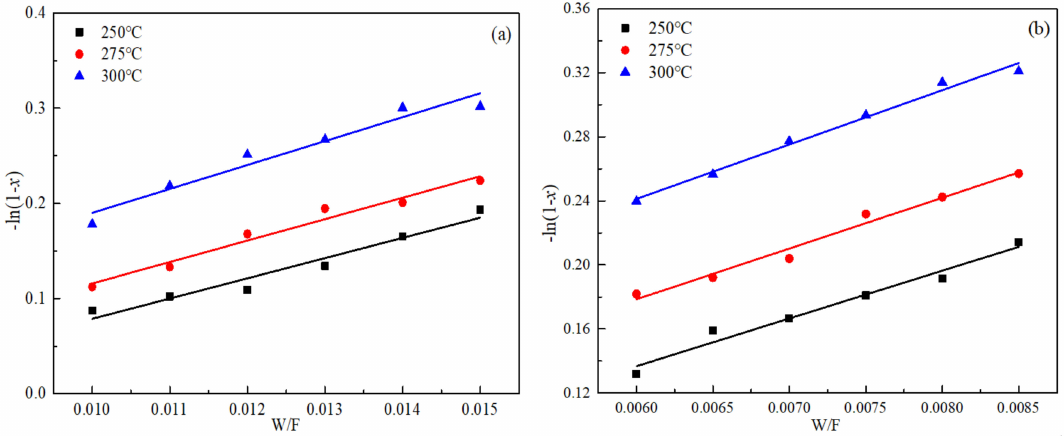
Figure 6. Trend chart of − ln(1 − x) with W/F at different temperatures: ( a ) SOC, ( b )